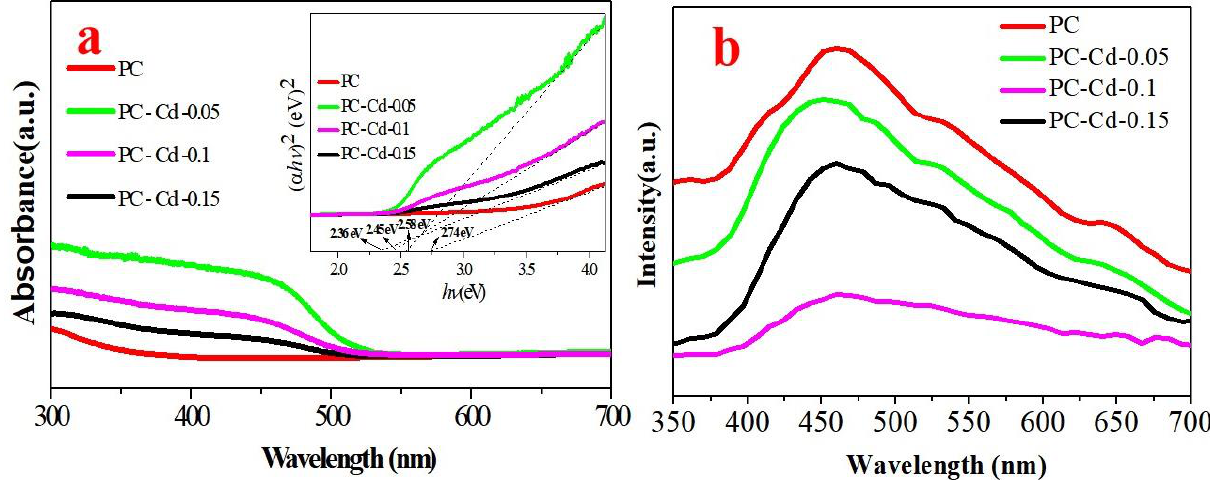
Figure 5. ( a ) The UV–visible spectra of PAN/g-C 3 N 4 /CdS heterojunctions with diverse CdS2 (inset: the corresponding ( αhν ) 2 ~ hν plot), ( b ) The PL spectra of PAN/g-C 3 N 4/ CdS heterojunctions with diverse CdS.